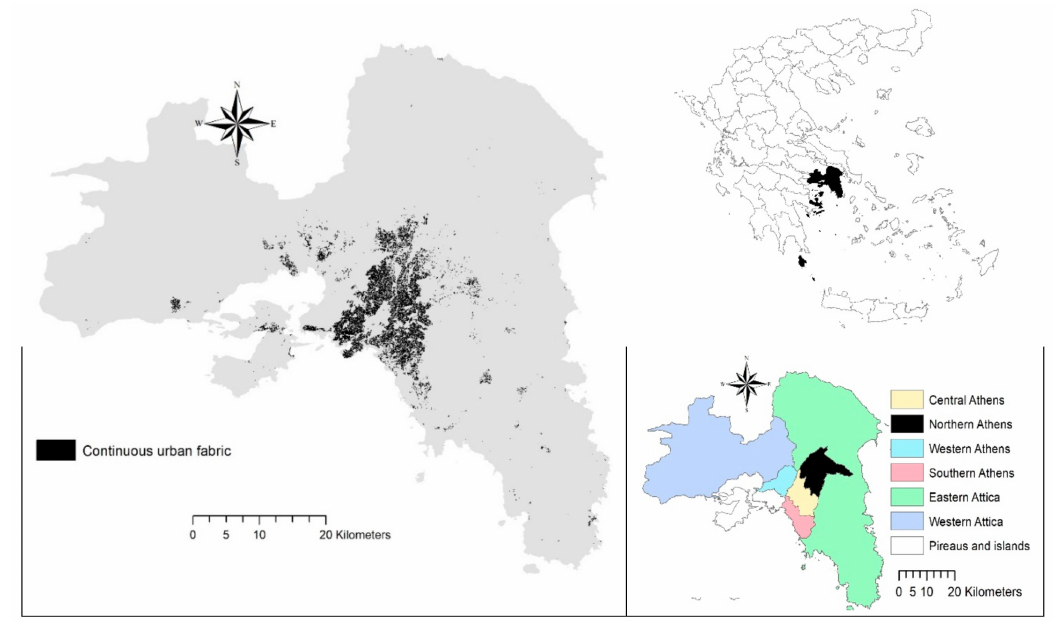
Figure 2. A map illustrating the extent of the study area and the spatial distribution of continuous urban fabric therein ( left ); the position of the study area in Greece ( upper right ) and the regional units of the study area ( lower right ); drawn from Urban Atlas and Greek Statistical O ffi ce (ELSTAT) shapefiles.